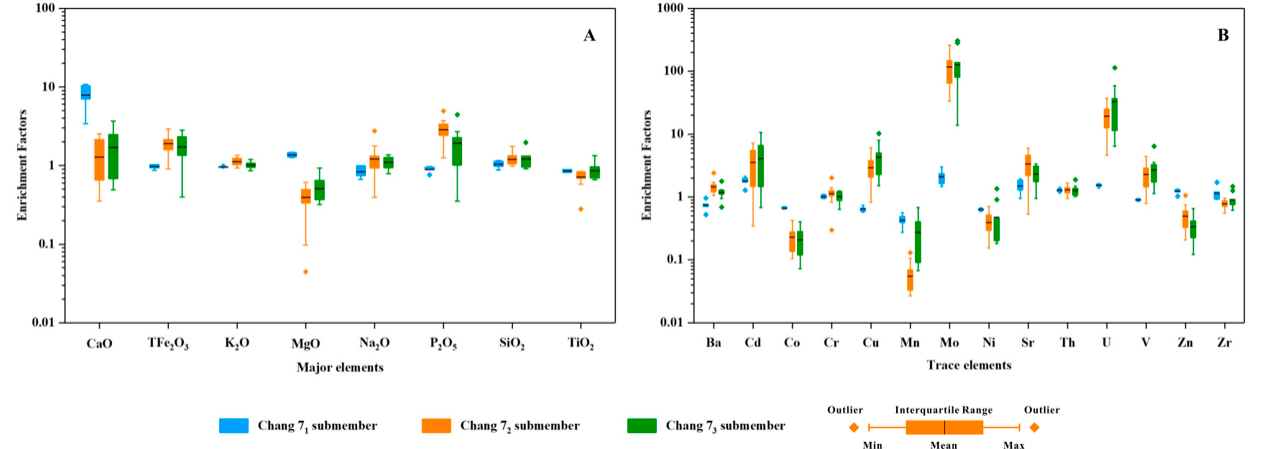
Figure 6. ( A ) Enrichment factors of the selected major elements relative to the PAAS [25] for the Chang 7 Member.; ( B ) EFs of trace elements of the Chang 7